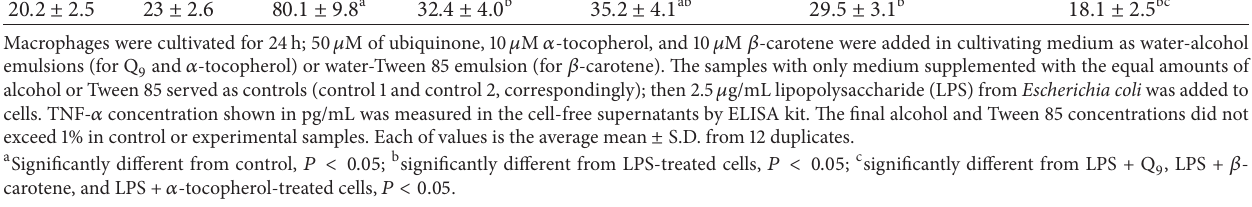
Table 1: Effect of in vitro added antioxidants on TNF- 𝛼 production in LPS-treated peritoneal macrophages from mice. Control 1